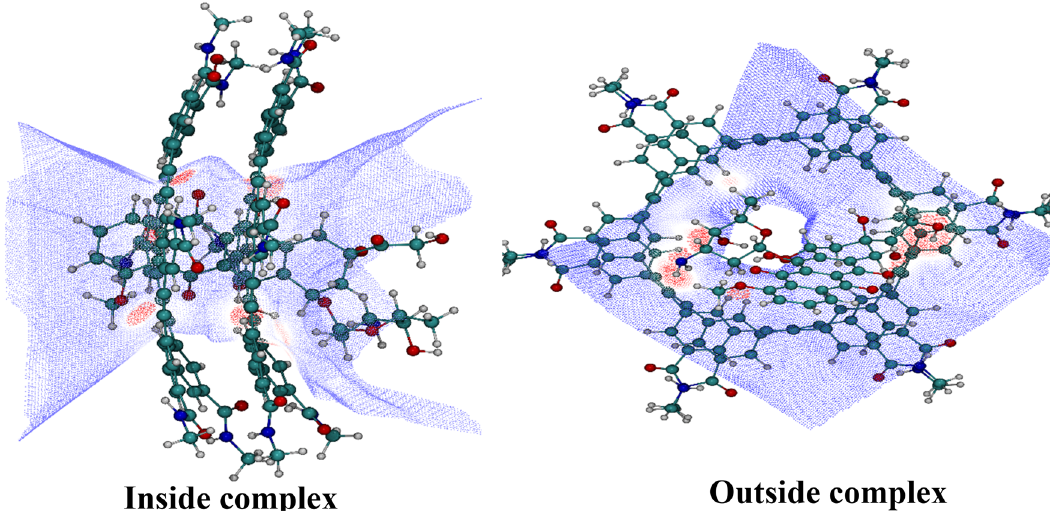
Figure 2. The colored Becke surface map of DOX drug in DOX-hexakis dimer complexes. Red zones in the maximized frames indicate regions of high electron density.